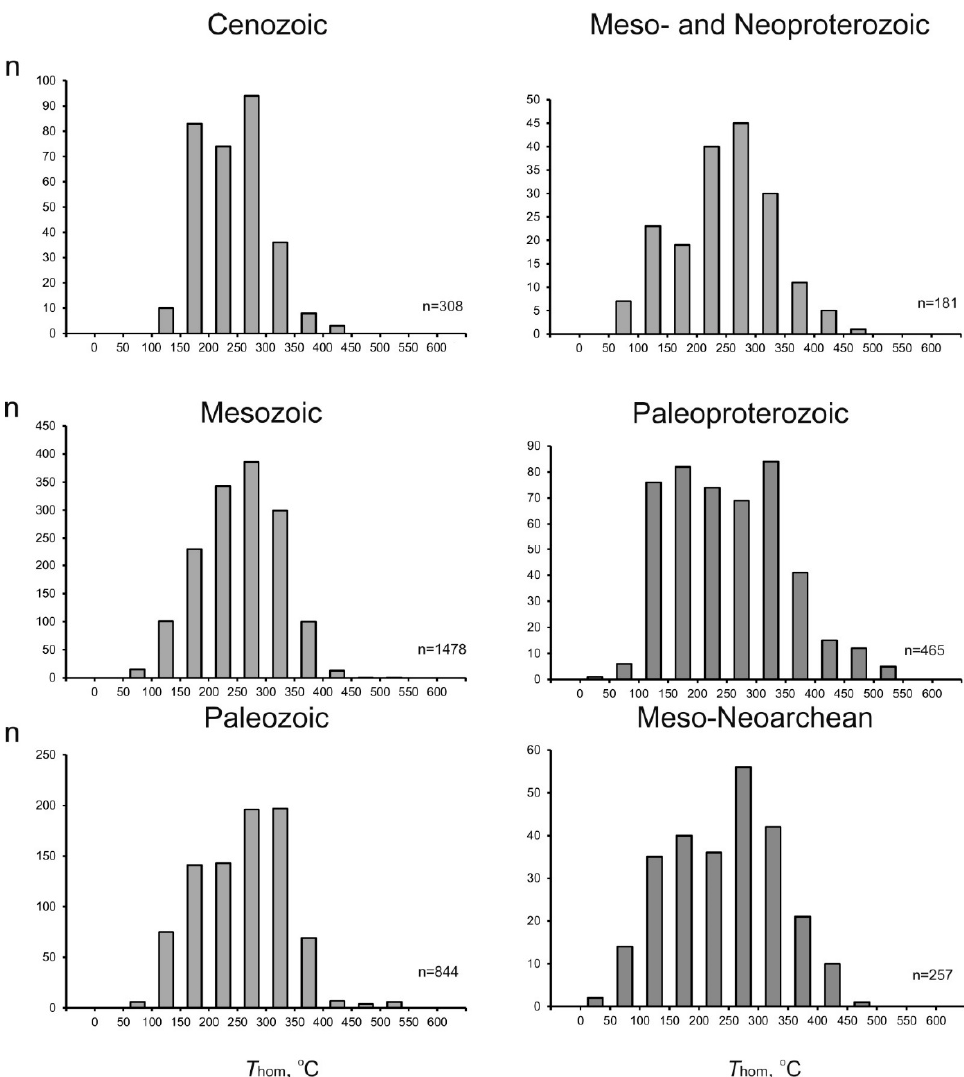
Figure 3. Histograms of the temperatures of mineralizing fluids at gold deposits of different age.